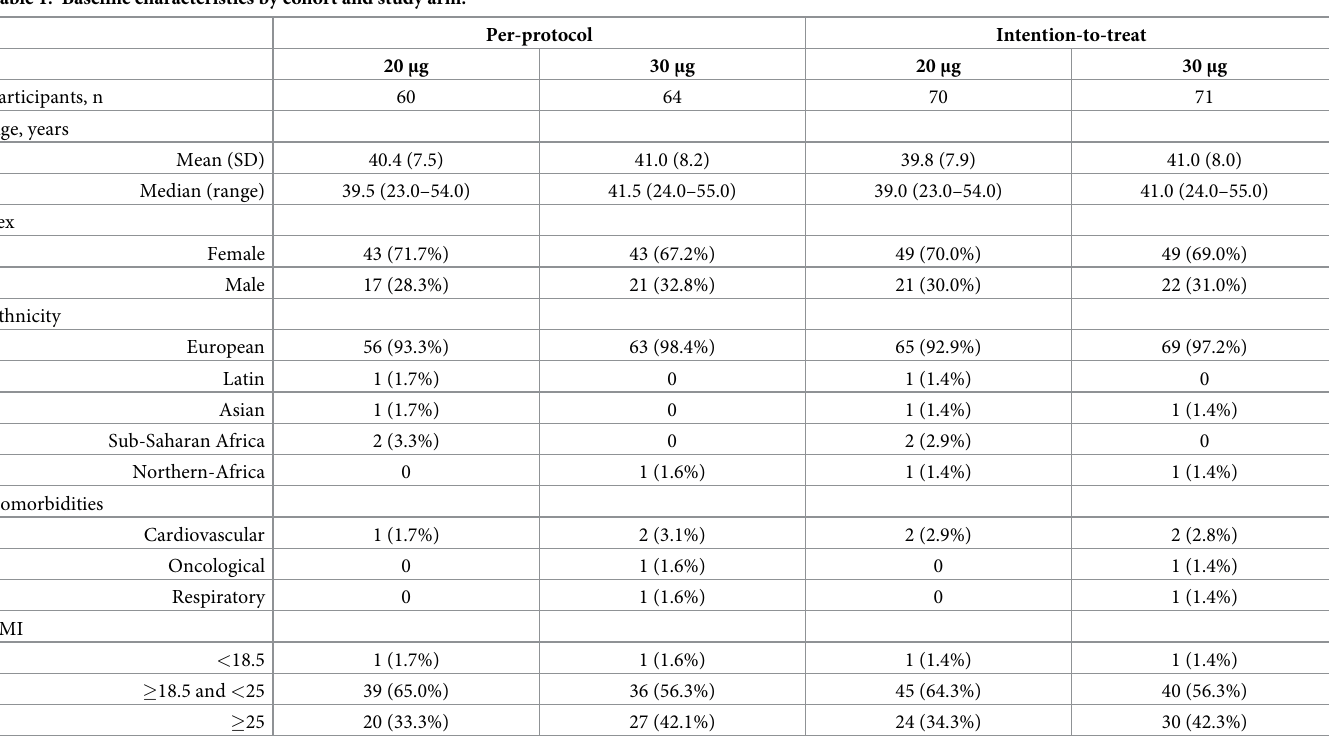
Table 1. Baseline characteristics by cohort and study arm.